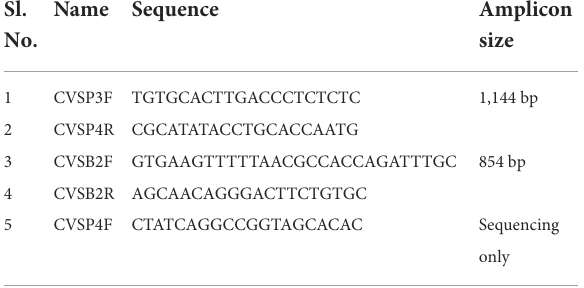
TABLE 1 Details of the primers used in the study. Sl.